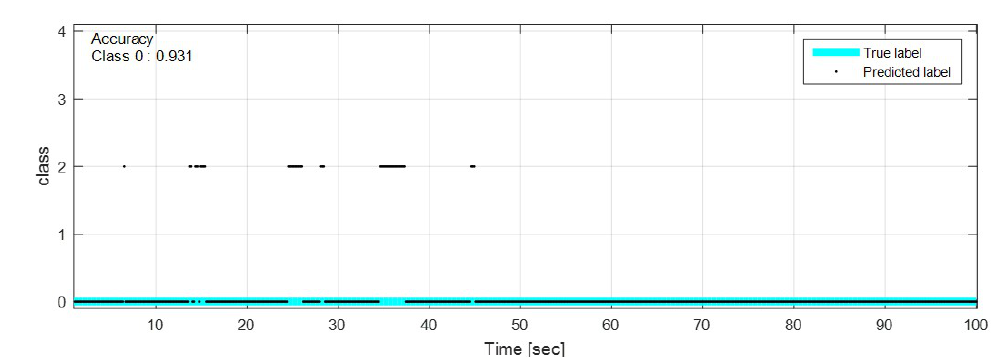
Figure 19. Prediction result on flat road, free speed (0 ∼ 100